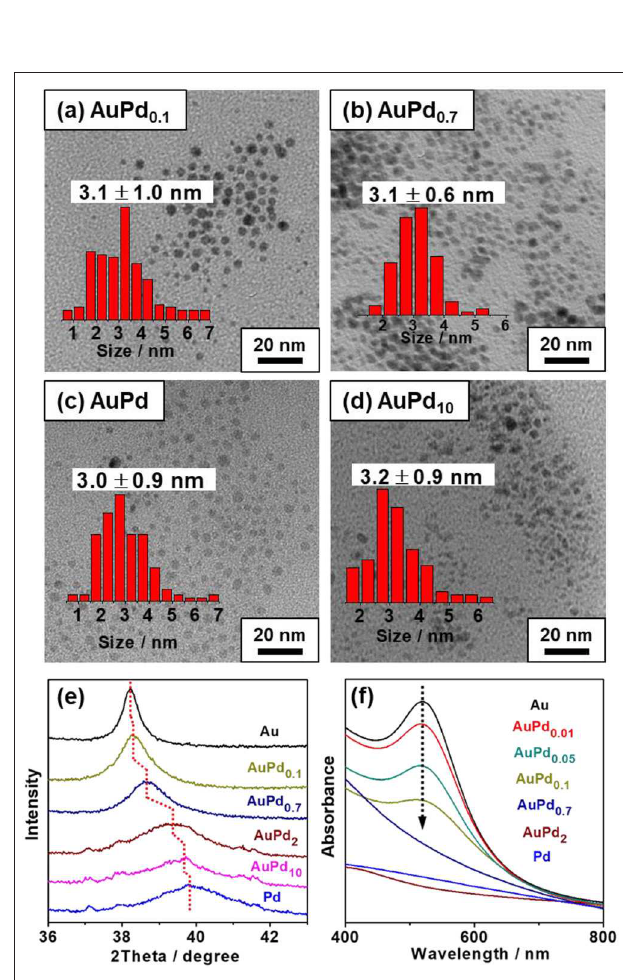
FIGURE 2 | TEM images and particle size distributions of colloidal AuPd x nanoparticles. (a) AuPd 0.1 , (b) AuPd 0.7 , (c) AuPd 1.0 , (d) AuPd 10 , (e) XRD, and (f) UV-vis spectrum of colloidal AuPd x